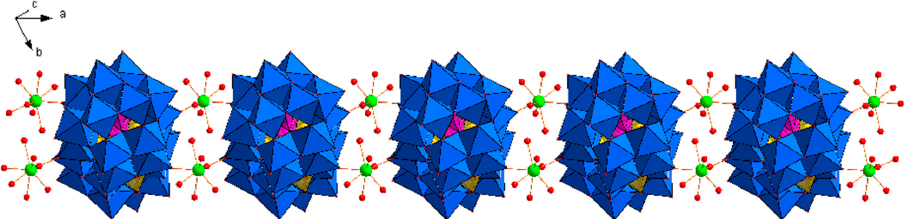
Figure 2. View of the one-dimensional (1D) ladder like chain in Dy 2 Mn 4 -P 2 W 15 . Color scheme: Dy = green; O = red; WO 6 octahedron = blue, MnO 6 octahedron = gold; PO 4 tetrahedron = Pink.